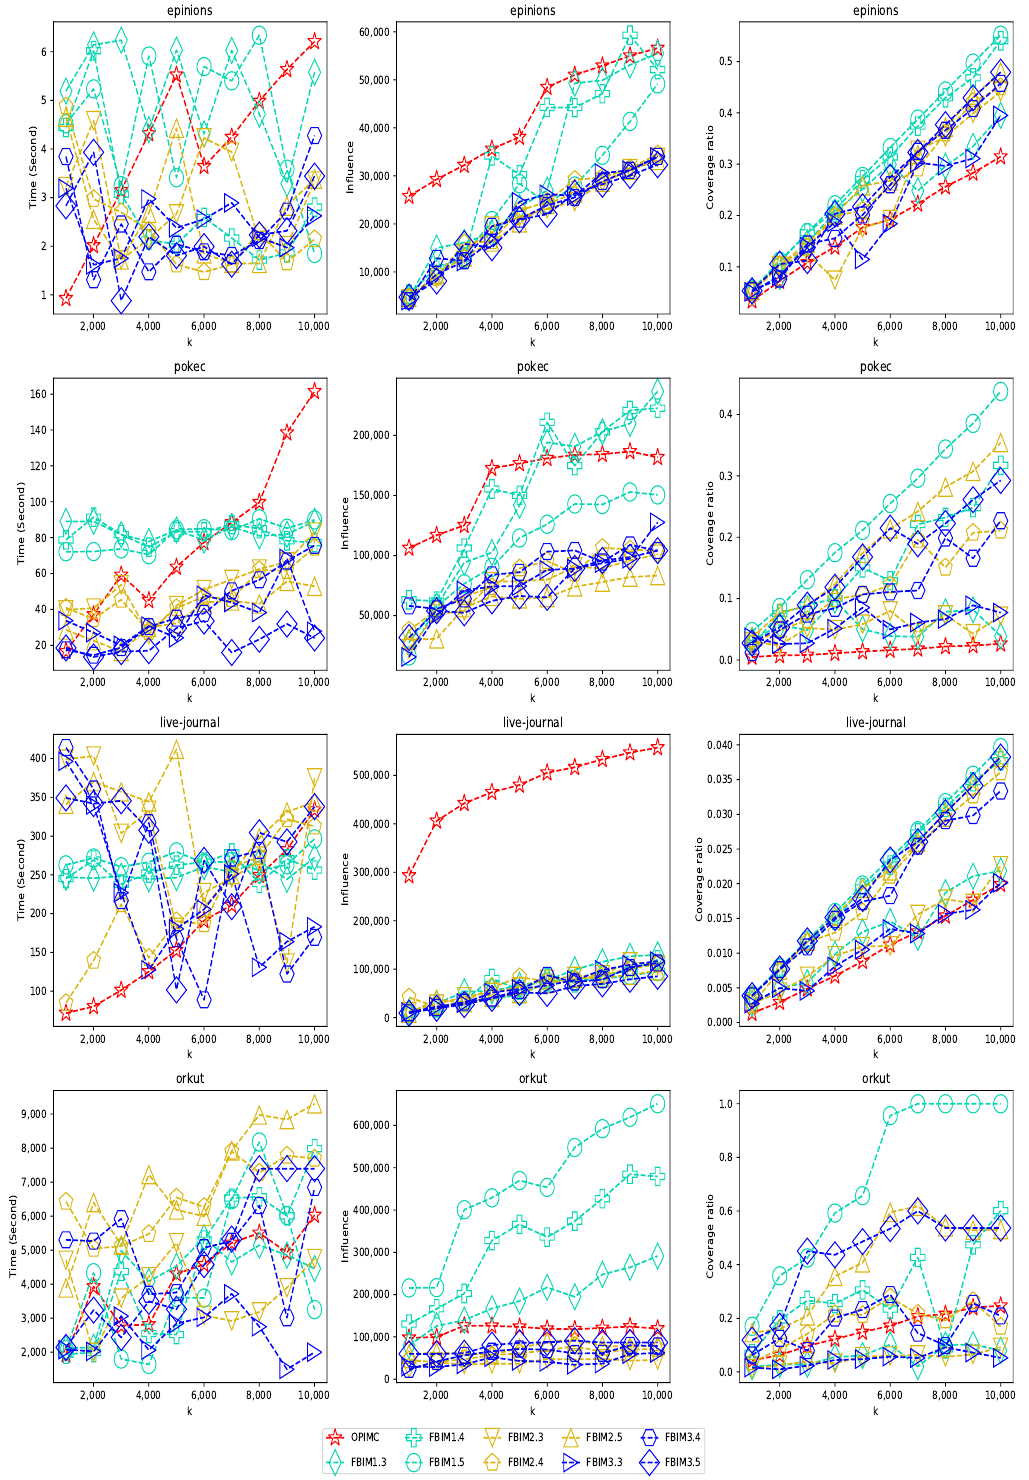
Figure 4. Running time, influence, and coverage ratio for Experiment 2 under the IC